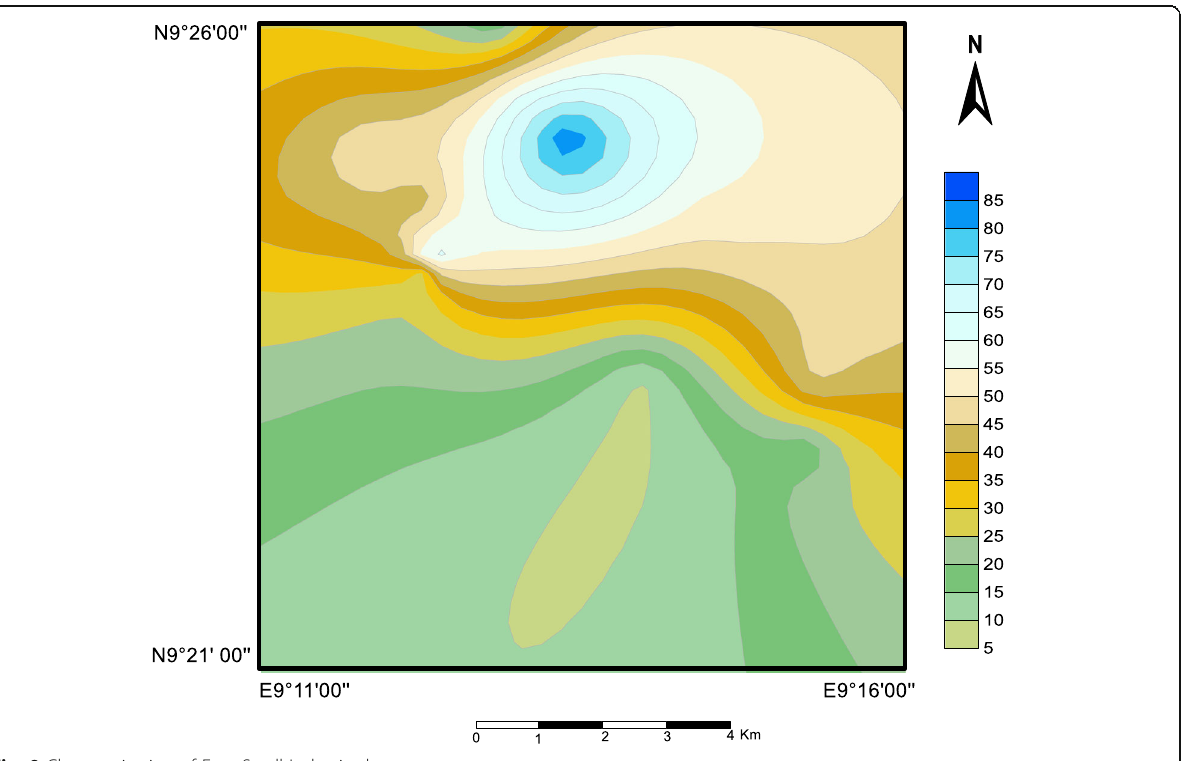
Fig. 9 Characterization of Free Swell Index in the